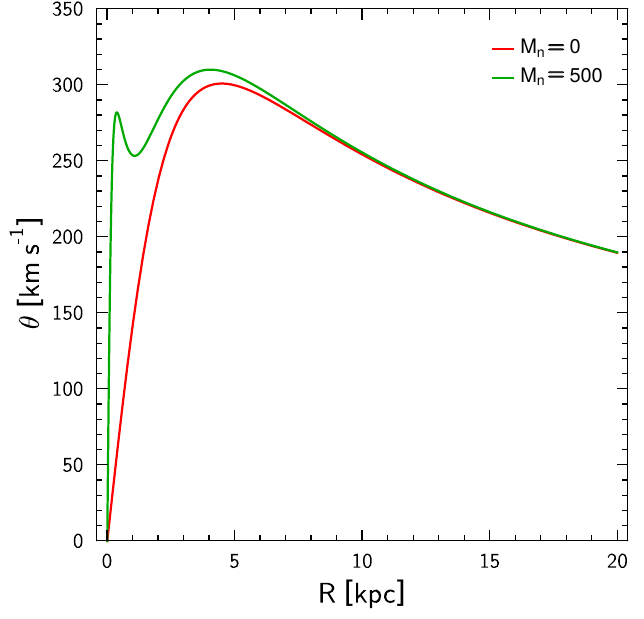
Fig. 1. A plot of the total circular velocity of our galactic model when M n = 0 and M d = 7500 (red) and when M n = 500 and M d = 7000